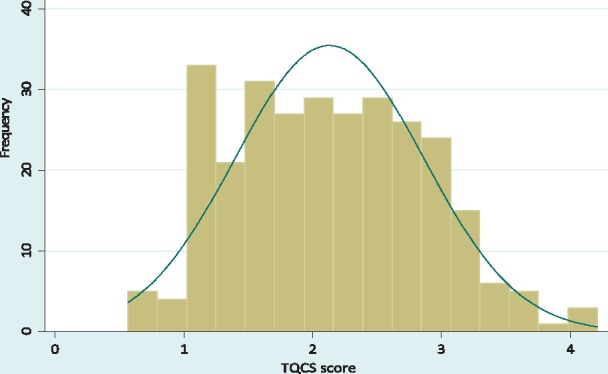
Normal distribution of the TQCS score